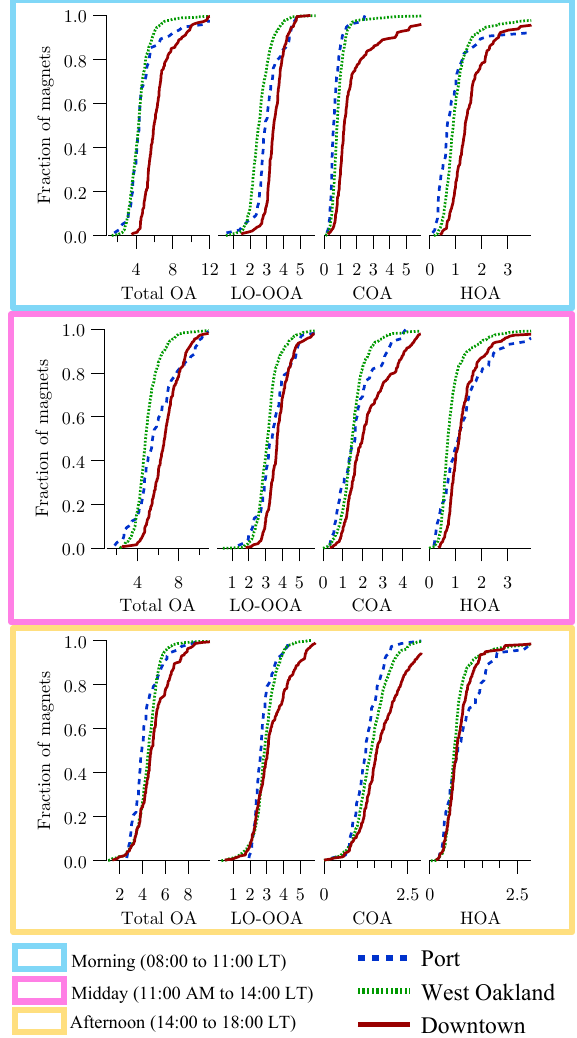
All horizontal axes are in units of µ g m -3 Figure 7. Cumulative distribution functions of total OA and the three factors identified in this study resolved by area (port, West Oakland, and downtown) and local time (LT) of day: morning (08:00 to 11:00), midday (11:00 to 14:00LT), and afternoon (14:00 to 18:00LT). The colored box around each set of CDFs indicates the period of the day those data